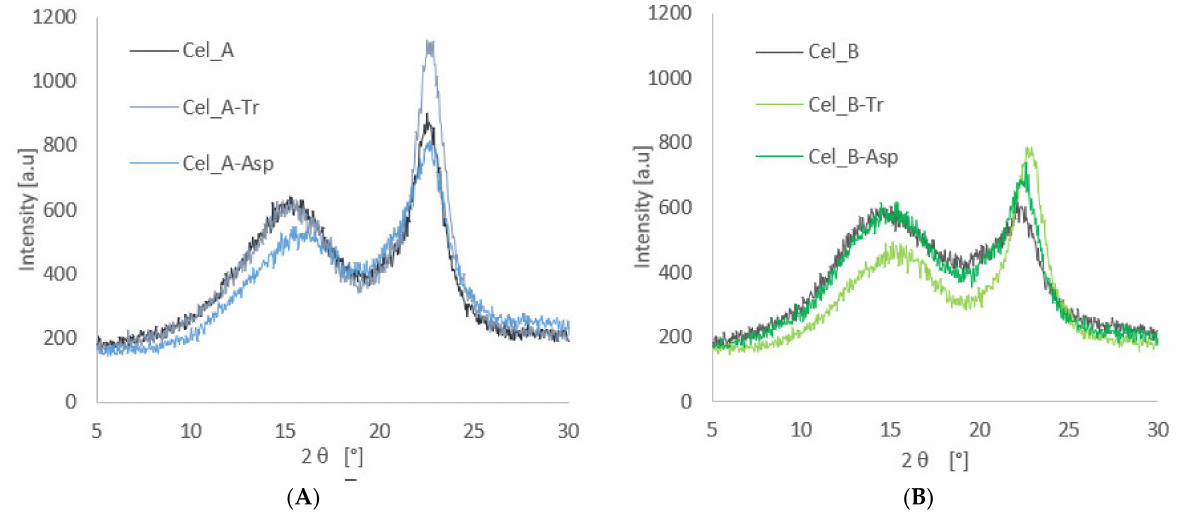
Figure 2. Diffractograms of cellulose Cel_A ( A ) and Cel_B ( B ) and celluloses hydrolyzed with